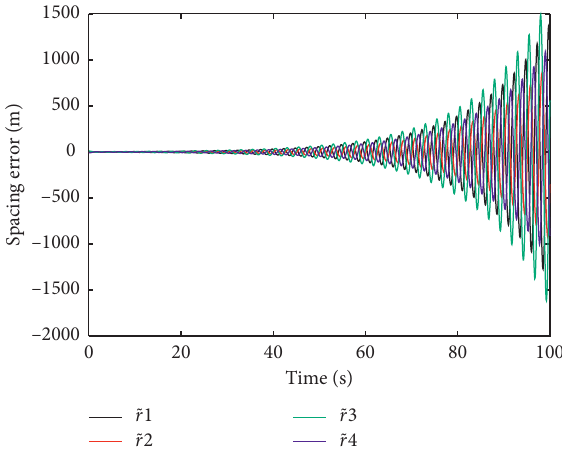
Figure 5: Spacing errors for an automated vehicular platoon under directed topology with τ � 0 . 35